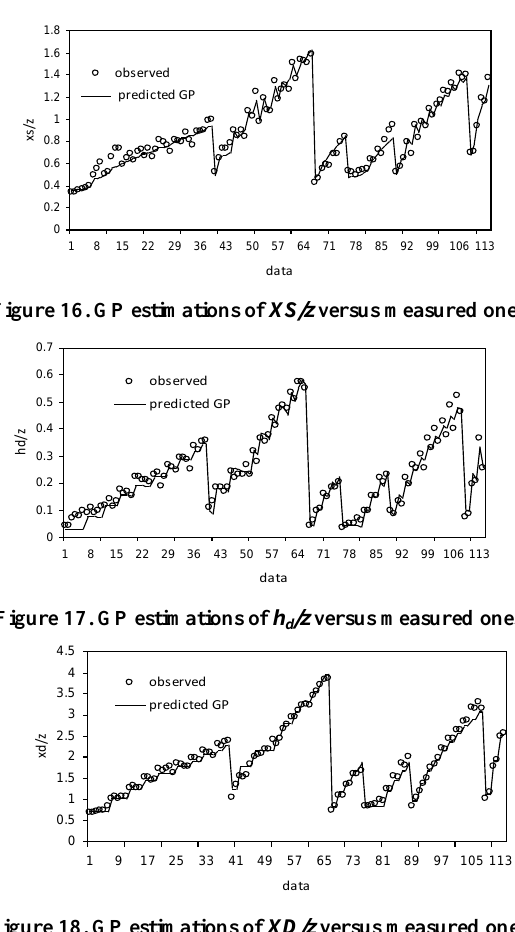
Figure 18. GP estimations of XD/z versus measured ones 00.020.040.060.080.10.120.140.16